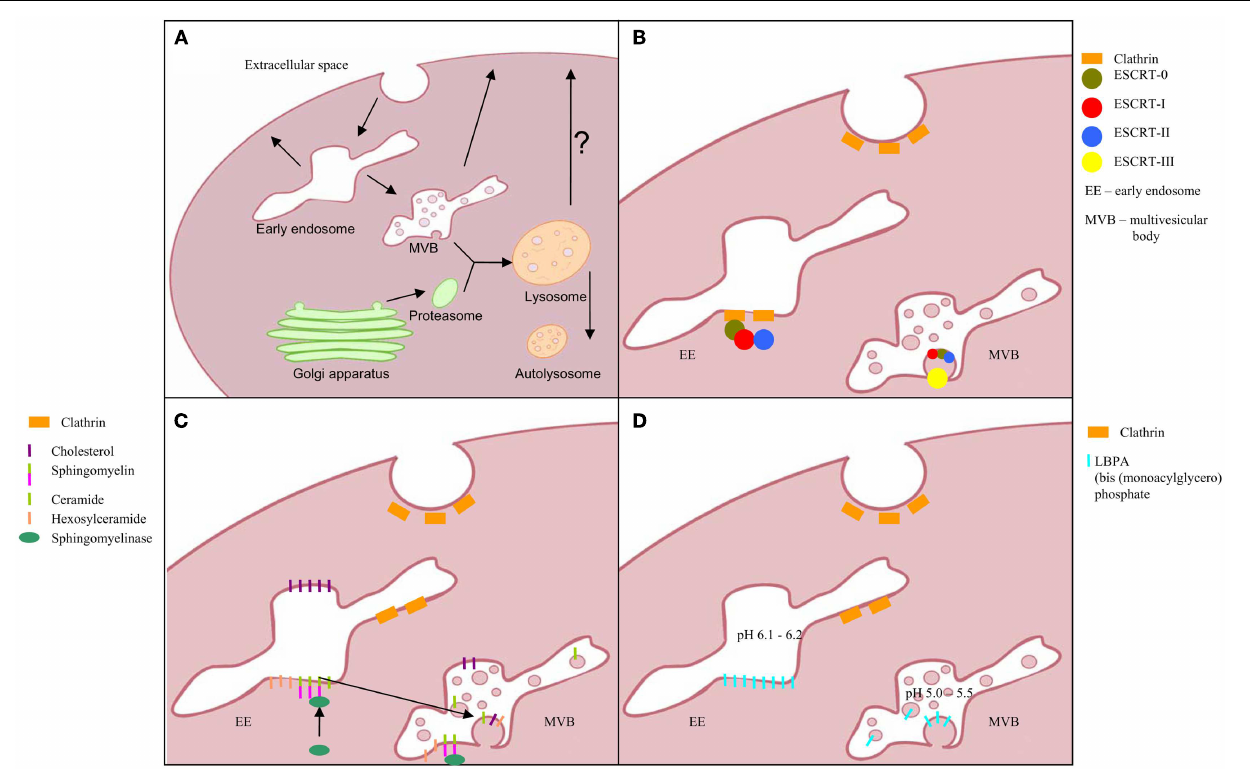
FIGURE 1 | Exosomes biogenesis; (A) multivesicular body formation; intraluminal vesicles formation pathway based on: (B) ESCRT complex involvement, (C) transformation of sphingomyelin into ceramide, and (D) triggered by phospholipid lysobisphosphatidic acid (LBPA) in acidic pH